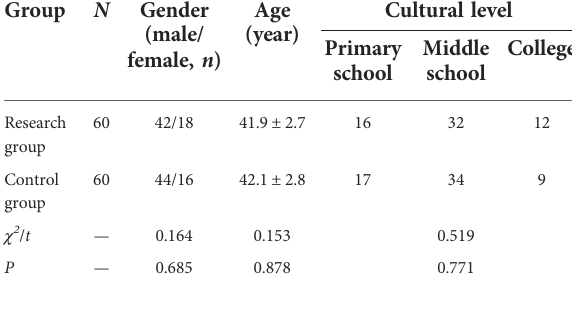
TABLE 1 Comparison of baseline data of two groups of